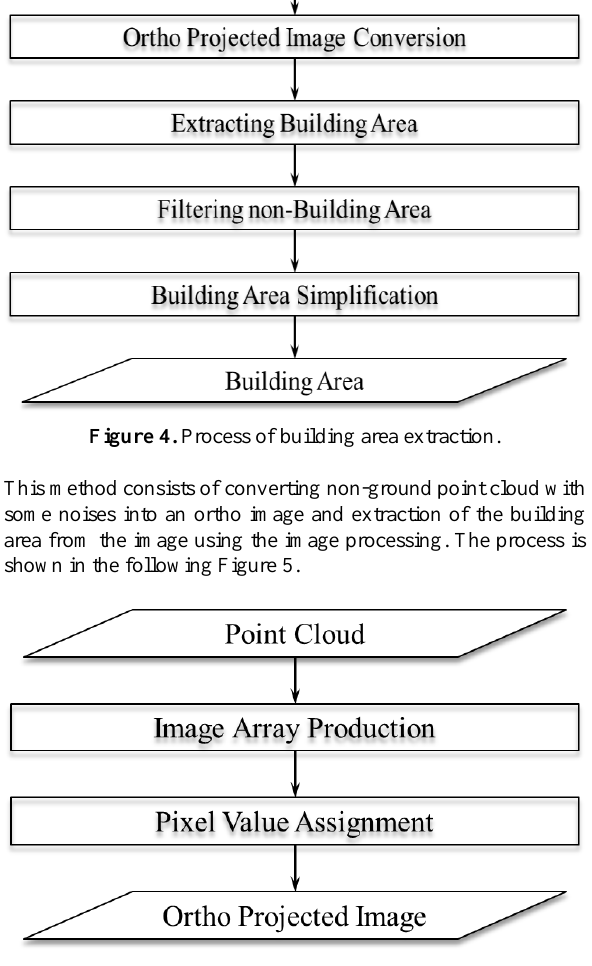
Figure 5. Process of converting into an ortho image